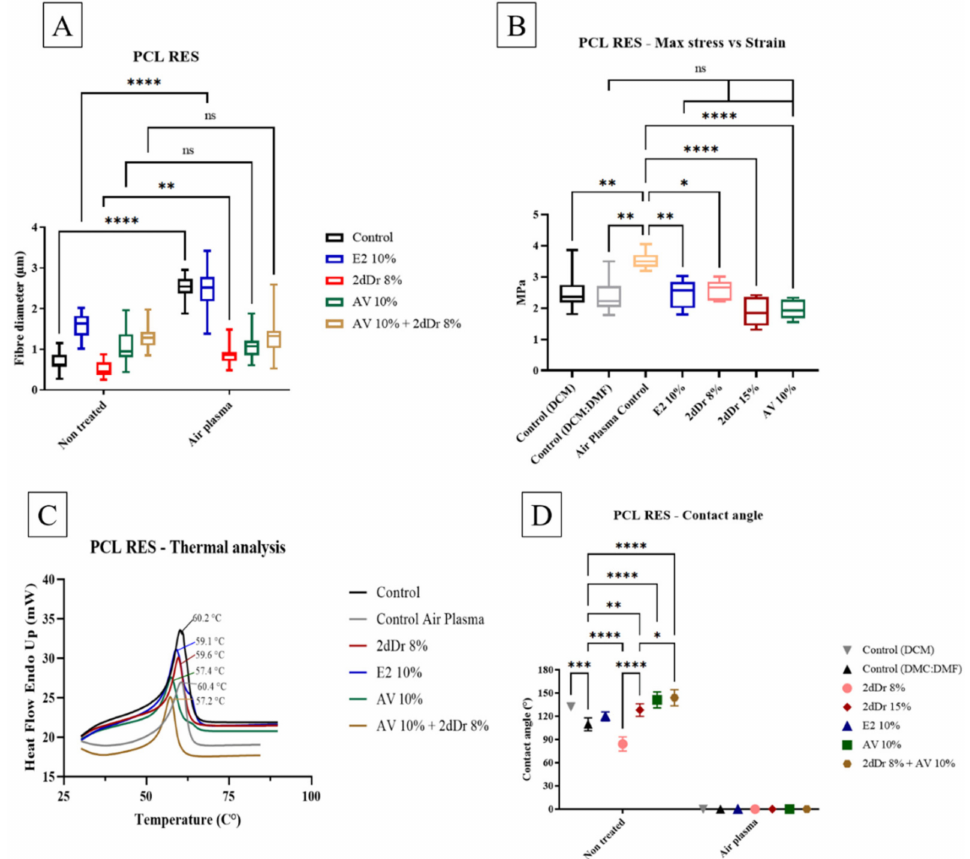
Figure 2. Physicochemical characterization of PCL RES. ( A ) Fiber diameter of PCL RES before and after air plasma treatment (N = 3, n = 15). ( B ) Tensile strength of PCL RES controls and loaded with bioactive compounds. ( C ) DCS of PCL RES loaded with bioactive compounds. ( D ) Contact angle of PCL RES loaded with bioactive compounds, before and after air plasma treatment. * p < 0.05, ** p < 0.01, *** p < 0.001, **** p < 0.0001. N = 2, n =